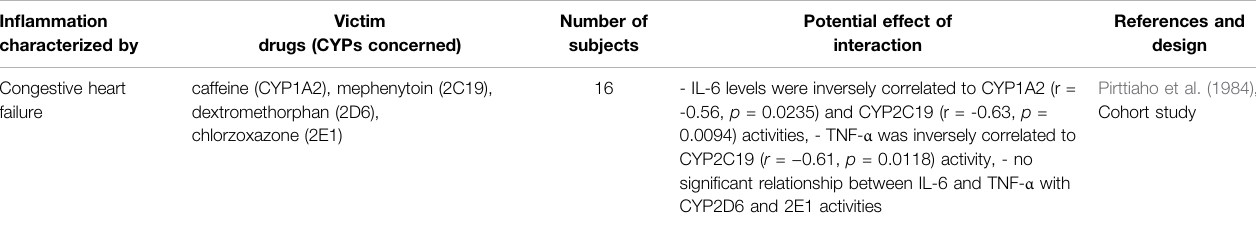
TABLE 7 | Impact of cardiac diseases on CYP substrates, explained totally or partially by modulation of CYP activity. In fl ammation characterized